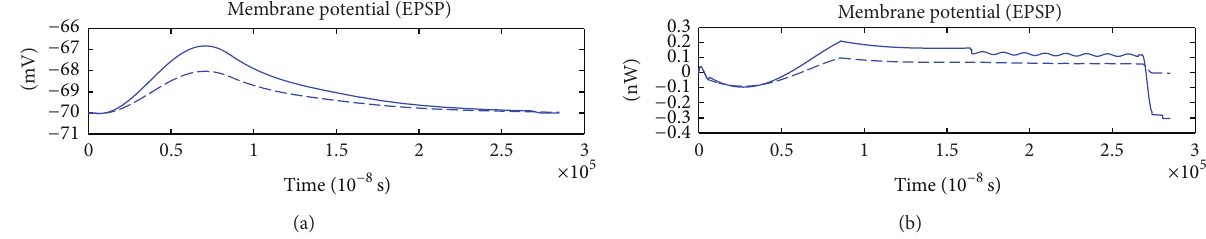
Figure 15: The EPSP and the corresponding energy function. 𝑟 0𝑚 = 0.0001 Ω , 𝑟 1𝑚 = 0.1 Ω , 𝑟 2𝑚 = 1000 Ω , 𝑟 3𝑚 = 0.1 Ω , 𝑟 𝑚 = 1000 Ω , = 1 𝜇𝐹 , 𝐿 = 50 𝜇𝐻 , 𝑖 = 7.155 𝜇 A, and 𝑄 = 3 × 10 −6 𝜇 A. 𝐶 𝑚 𝑚 0𝑚